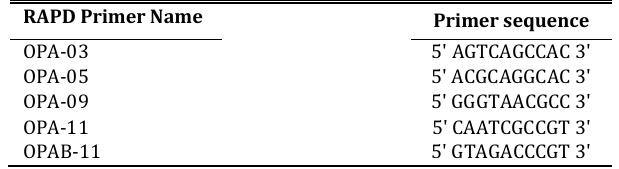
Table 1. RAPD primers used in this study